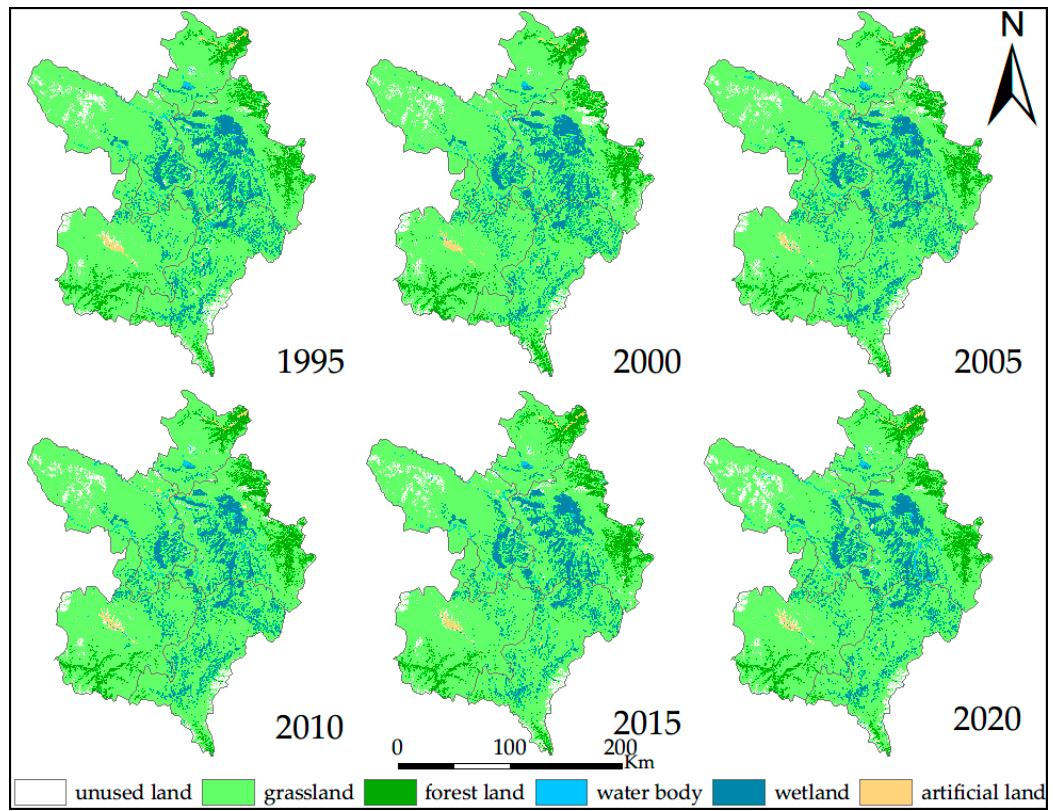
Figure 3. Alpine wetland distribution in ZP for different periods.